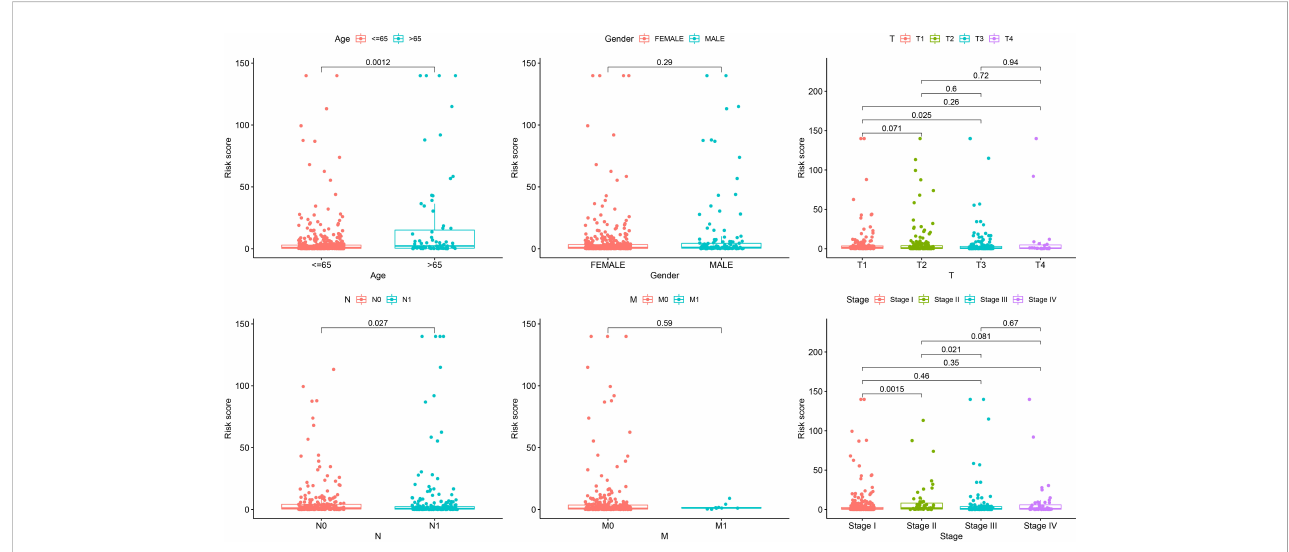
FIGURE 5 Correlation analysis showing that the senescence-related signature is associated with age, gender, T stage, N stage, M stage, and clinical stage.